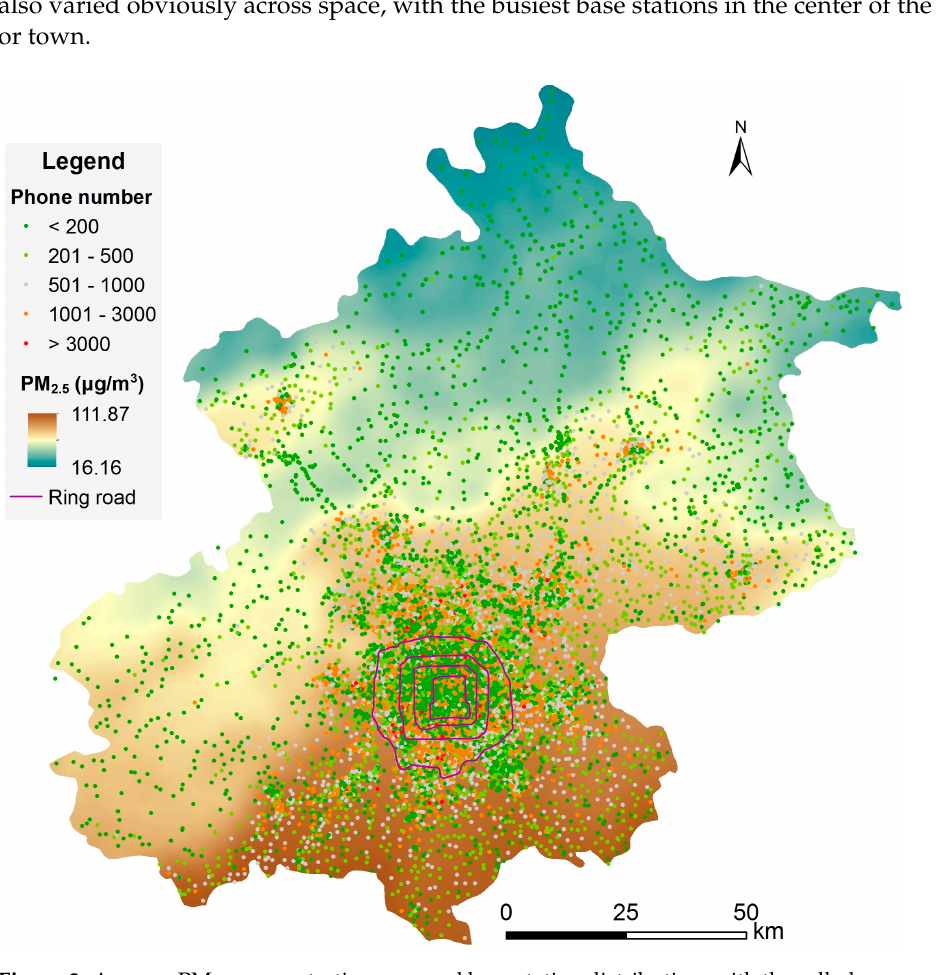
Figure 2. Average PM 2.5 concentration map and base station distribution, with the cell phone number of each base station at 15:00.